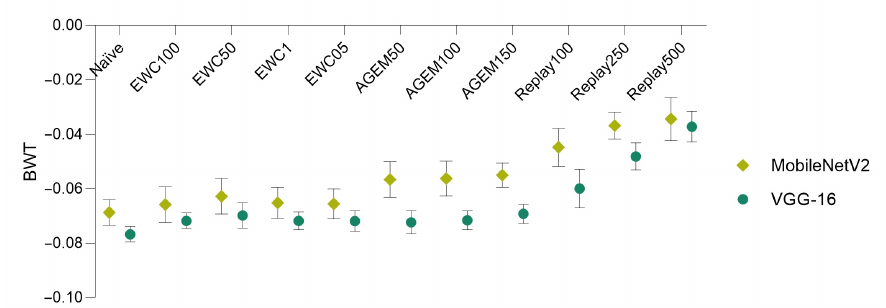
Figure 4. Model comparison in terms of backward transfer. Results averaged over 10 iterations ( ± SD).